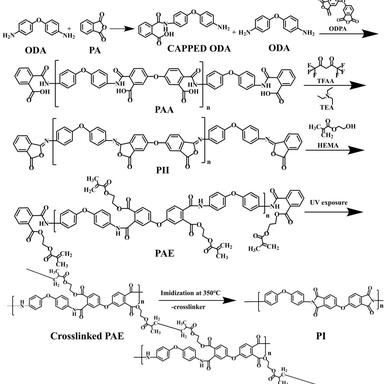
Synthesis process of PAEs and the principle of chemical changes during Photolithography Process and imidization.